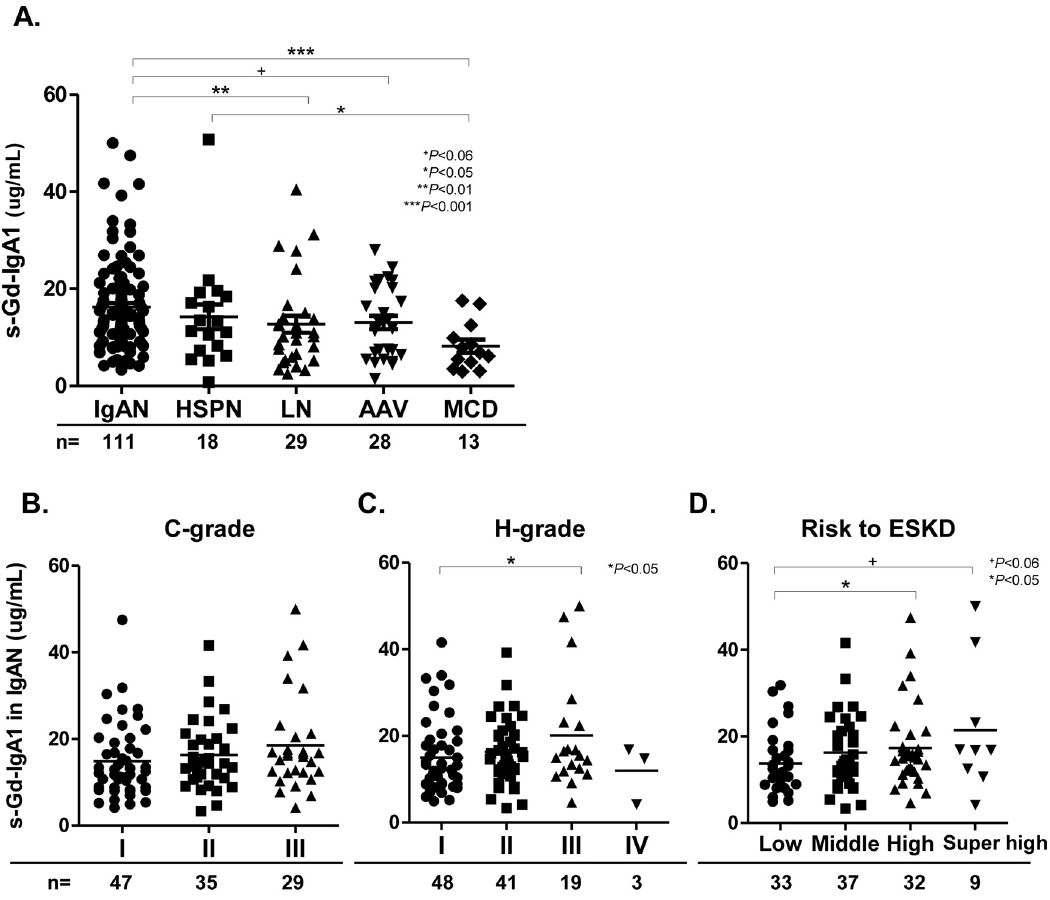
Fig 1. Serum-Gd-IgA1 levels determined by ELISA using KM55. Serum-Gd-IgA1 in patients with IgAN, HPN, LN, AAV, and MCD (A) . S-Gd-IgA1 in patients with IgAN according to JSN classification in terms of clinical grade (B) , histological grade (C) , and risk classification of progression to ESKD (D) . Horizontal solid lines represent means. Data were statistically analyzed using Kruskal- Wallis tests and Mann-Whitney U tests.